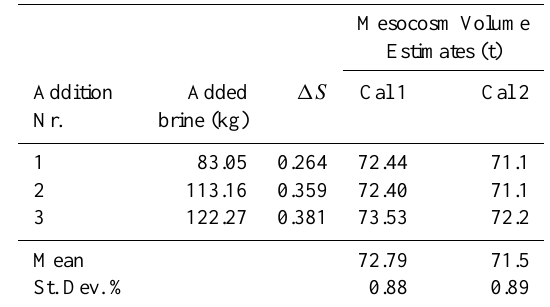
Table 1. Volumes calculated for three salinity additions to the same mesocosm using two calibrations, Cal 1 and Cal 2, were applied to each individual salinity increase. Results were corrected for in- creasing volume due to the addition of brine.